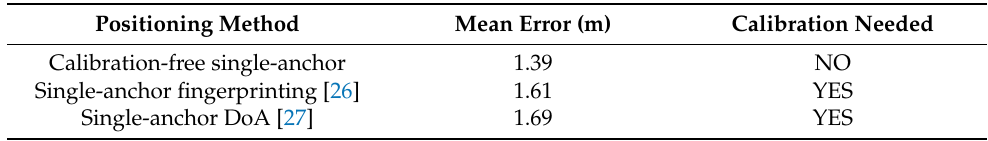
Table 5. Comparison of accuracy results for the presented approach and other single-anchor indoor positioning